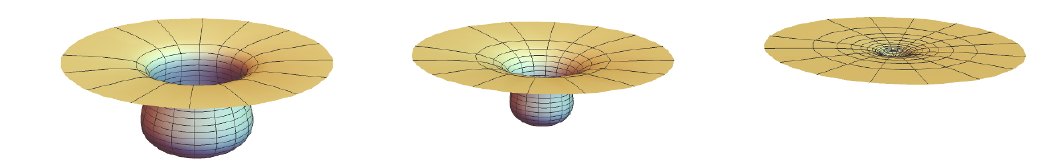
Figure 3 . The schematic diagrams for an evaporating black hole that ends up with a Planck-scale internal space, from left to right in time sequence. Note that the notion of distance is distorted in the